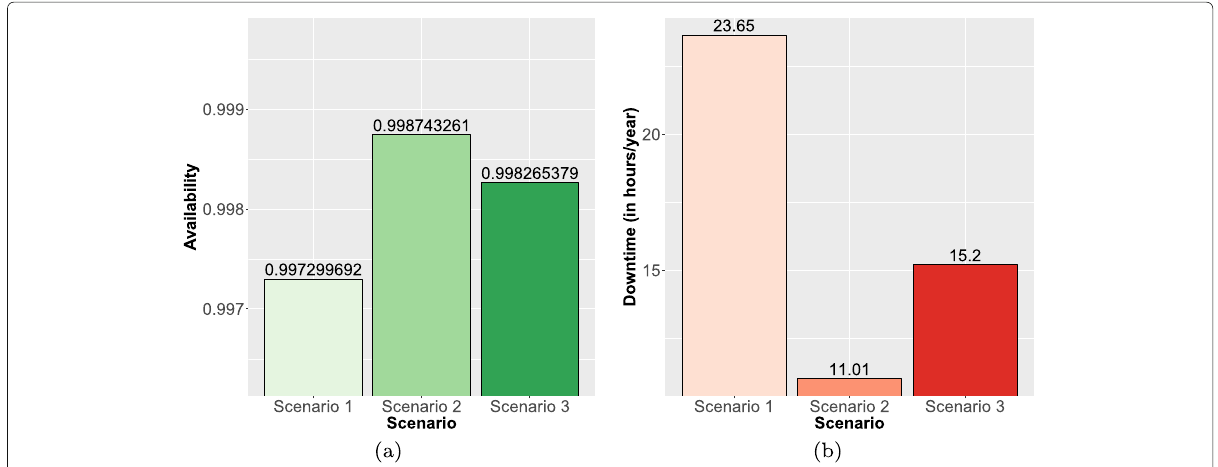
Fig. 13 a Availability levels and b downtime regarding the e-health monitoring system considering the three scenarios